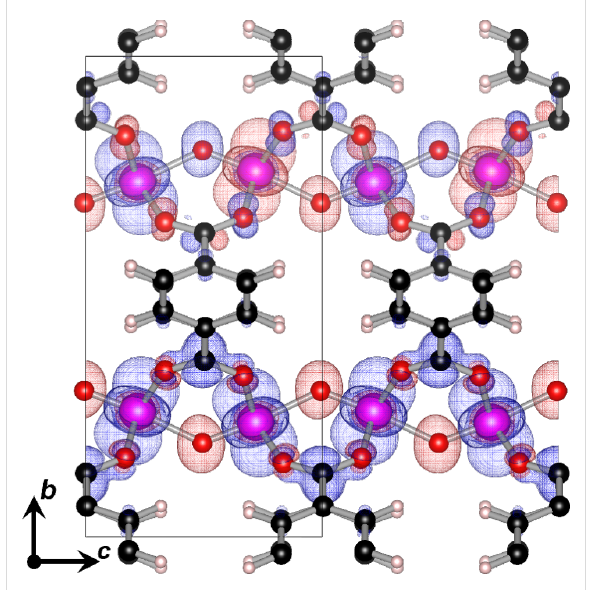
Figure 3: The spin density distribution of the SFM system. The upper chain has an antiferromagnetic spin configuration, while the lower chain has a ferromagnetic spin configuration. The iso-surface is taken at 0.00125, with majority spin shown in blue, and minority in red. The black rectangle indicates a single unit cell.